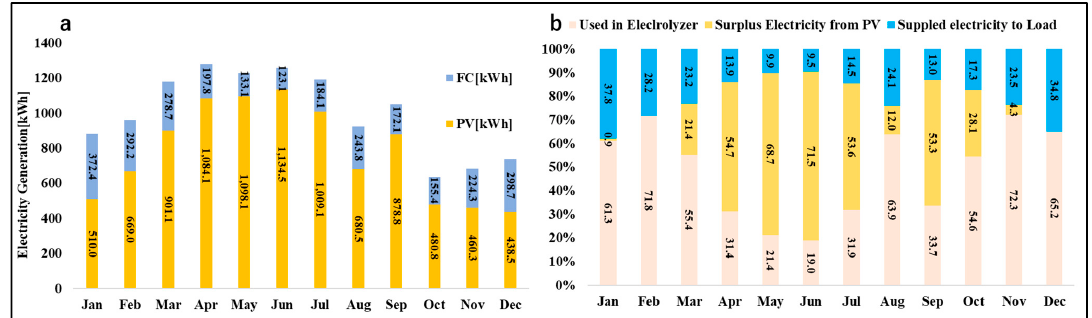
Figure 9. Hourly simulation of the electricity supply / demand in scenario 1: ( a ) January 1–January 4; ( b ) April 1–April 4).